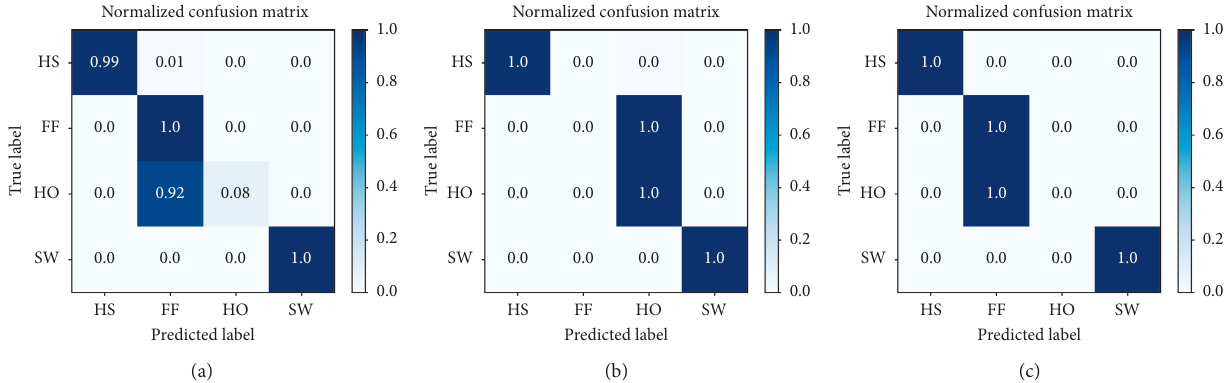
Figure 8: Confusion matrix of three gait patterns derived from bagging classification under three pace settings: 0.78m/s (a), 1.0 m/s (b), and 1.25m/s (c) classes.